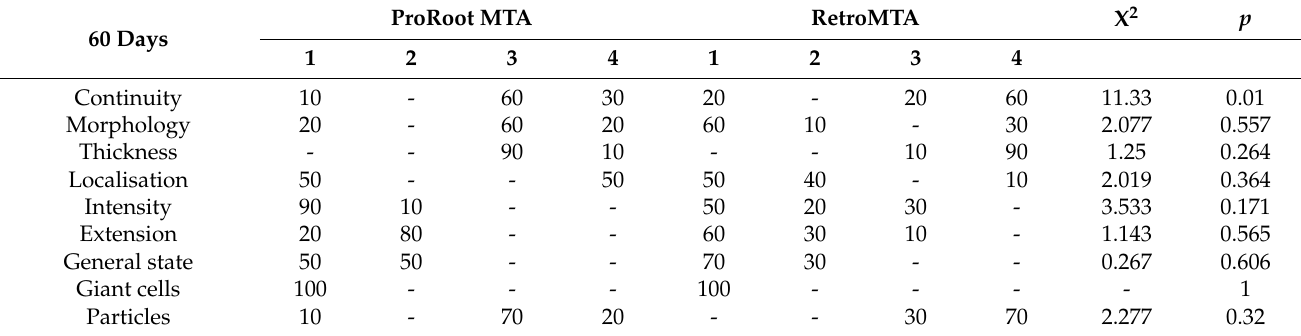
Table 6. Percentage of scores (%) attributed to each group in each criterion of hard tissue bridge after 60 days for both cement types: ProRoot MTA and RetroMTA.